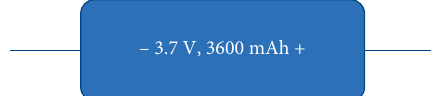
Figure 3: Single cell